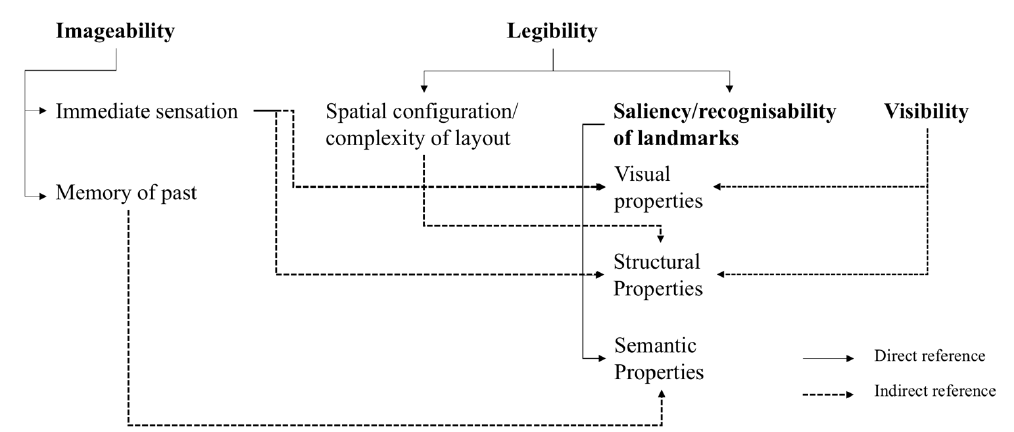
Figure 1. The conceptual relationship between imageability and